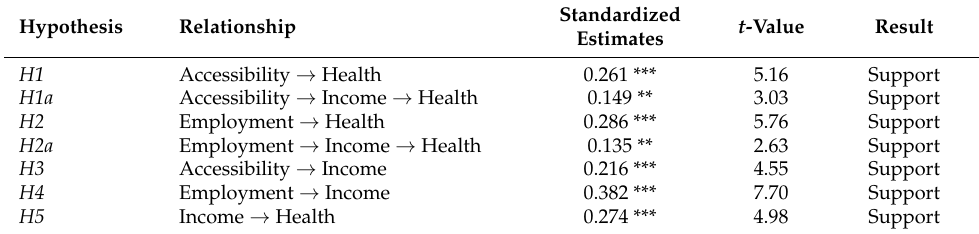
Table 5. Hypothesis